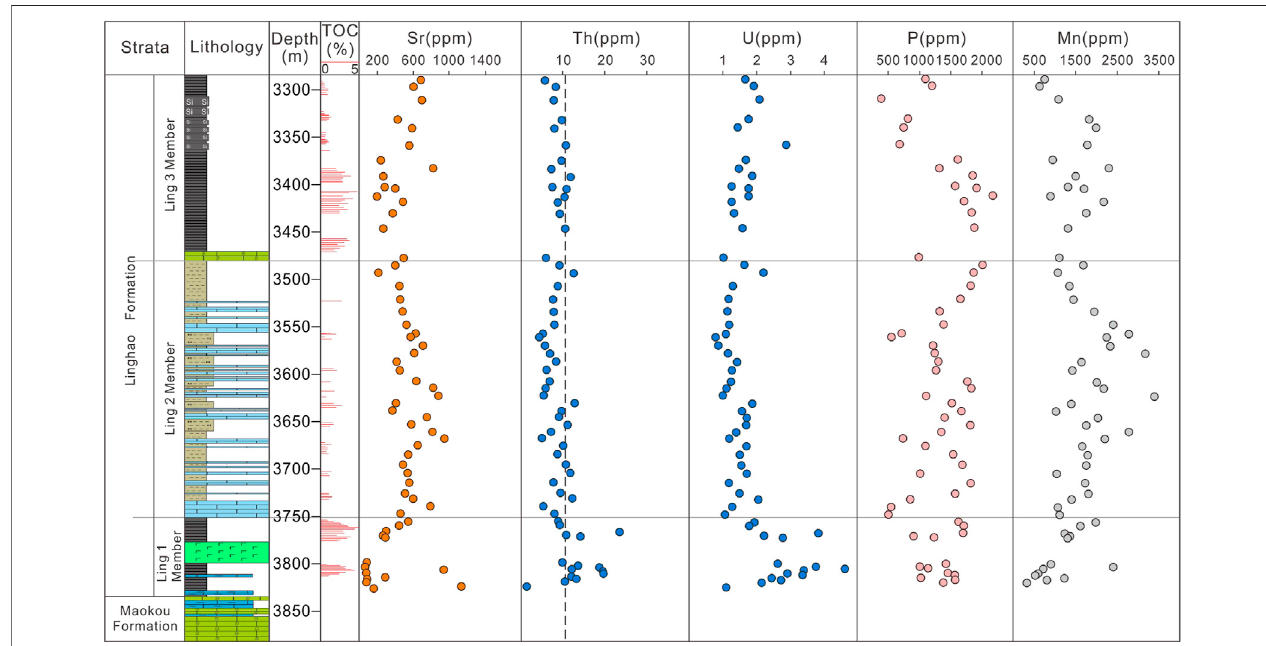
FIGURE 7 | Major and trace elements contents for Linghao Formation marine shale from the studied well in the central Nanpanjiang basin (2). Dashed lines represent the upper continental crust value for the corresponding element (McLennan, 2001)